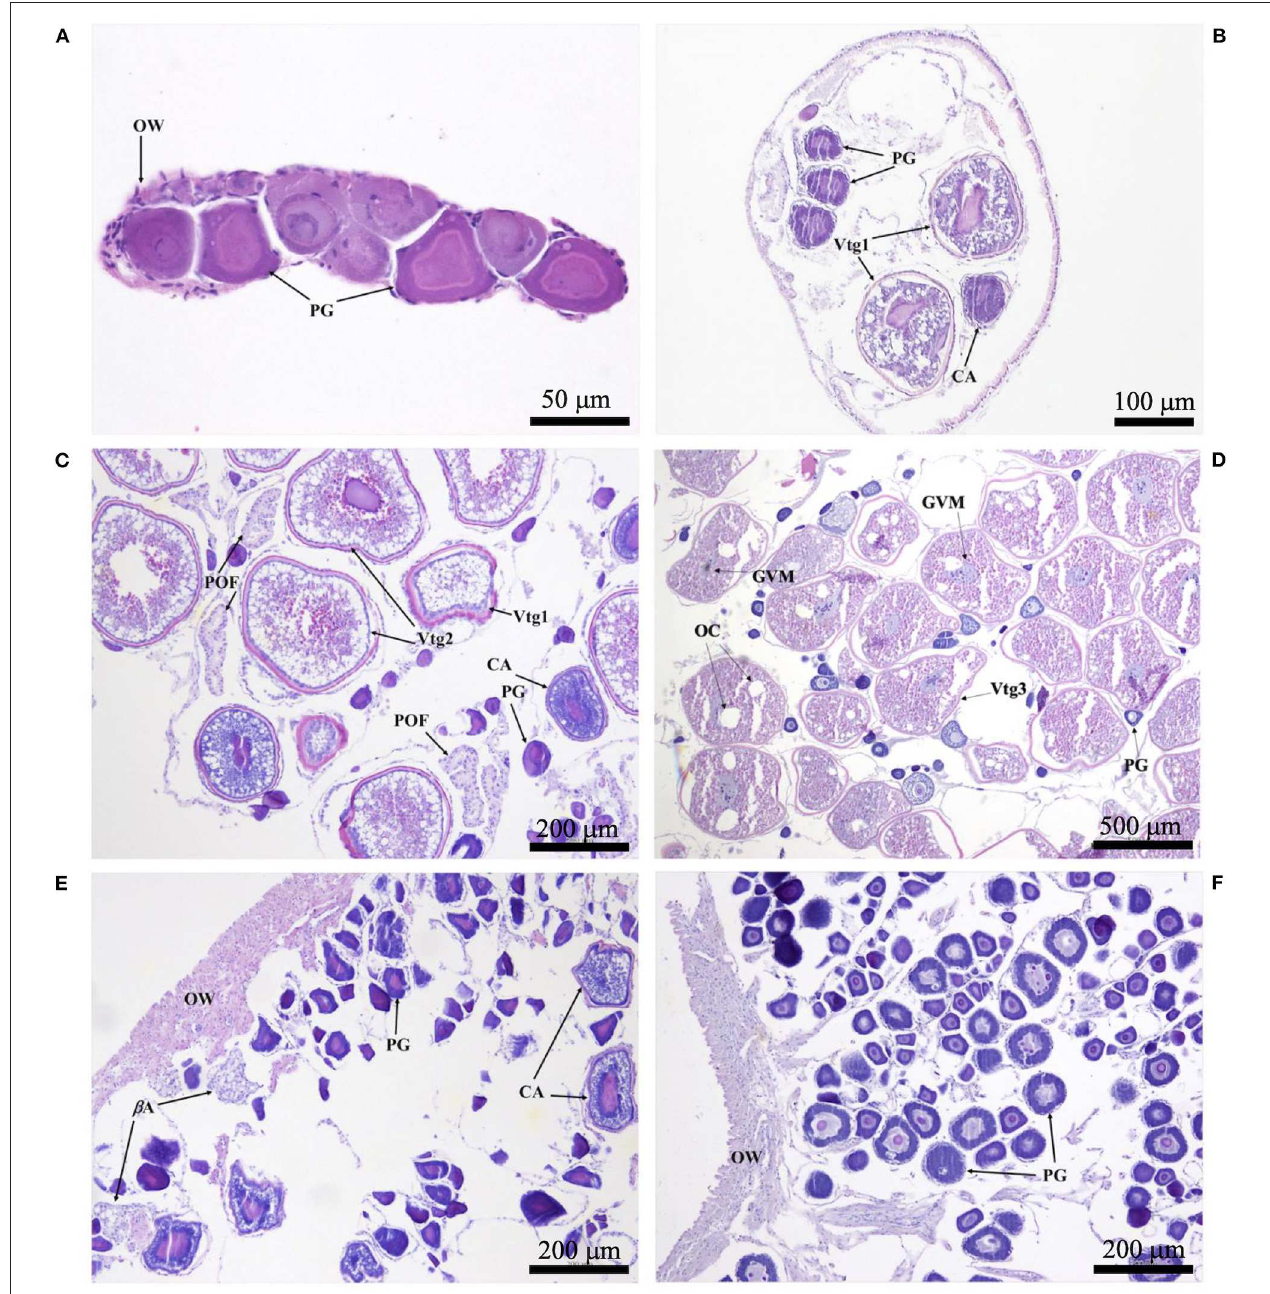
FIGURE 3 | Photomicrographs of ovarian histology, depicting: (A) Photostomias guernei in the immature phase, with only primary growth oocytes (PG) and a thin ovarian wall (OW); scale bar = 50 µ m; (B) Eustomias hypopsilus in the developing phase, with PG, cortical alveolar oocytes (CA), and primary vitellogenic oocytes (Vtg1); scale bar = 100 µ m; (C) Aristostomias xenostoma in the spawning capable phase, with PG, CA, primary and secondary vitellogenic oocytes (Vtg1 & Vtg2), and postovulatory follicles (POF); scale bar = 200 µ m; (D) Echiostoma barbatum in the actively spawning subphase undergoing oocyte maturation, with PG, tertiary vitellogenic oocytes (Vtg3), oil coalescence (OC), and germinal vesicle migration (GVM); scale bar = 500 µ m; (E) Aristostomias xenostoma in the regressing phase, with beta atresia ( β A), PG, and few CA; scale bar = 200 µ m; (F) Eustomias schmidti in the regenerating phase, with larger PG and a thicker OW; scale bar = 200 µ m.